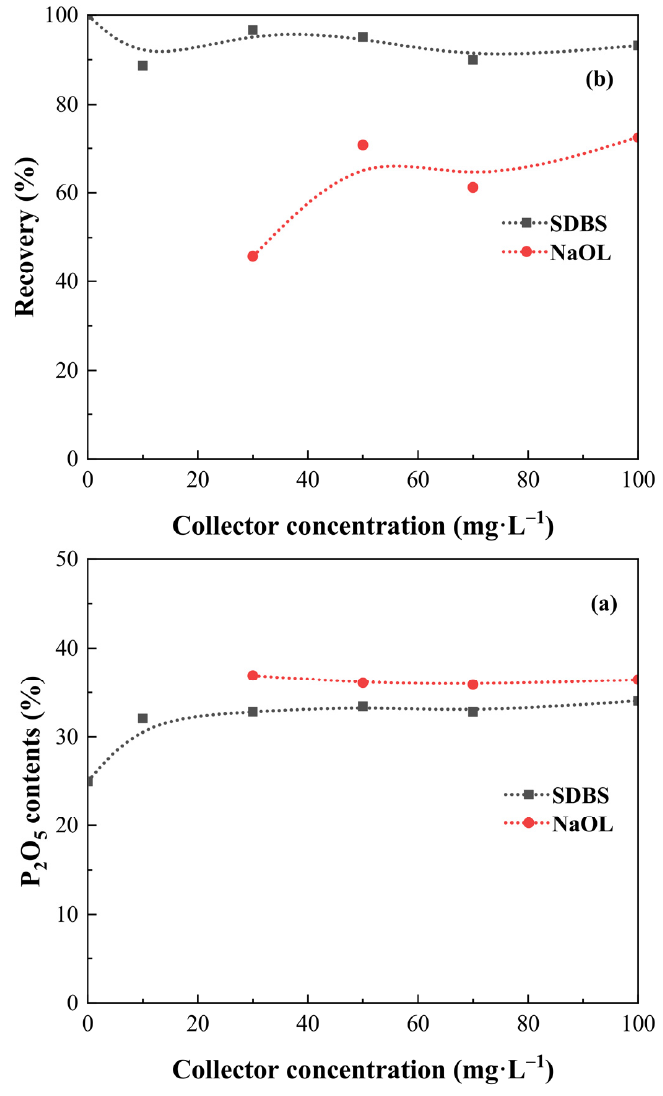
Figure 5. Effect of SDBS concentration on the ( a ) P 2 O 5 contents and ( b ) recovery (pH = 9.6, temperature = 15 ◦ C ±